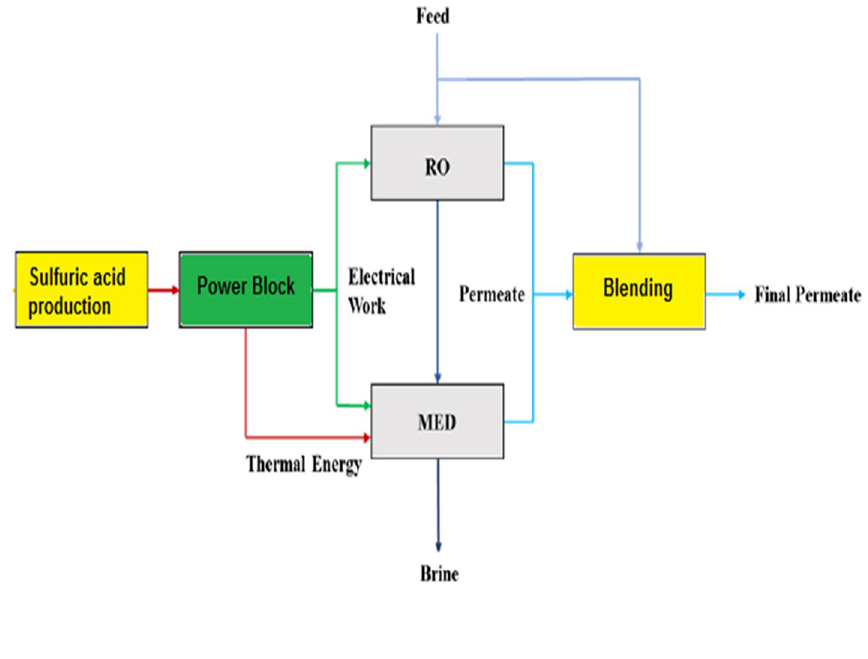
Fig. 7 Block diagram of power and water cogeneration by RO with hydraulic turbine without thermal